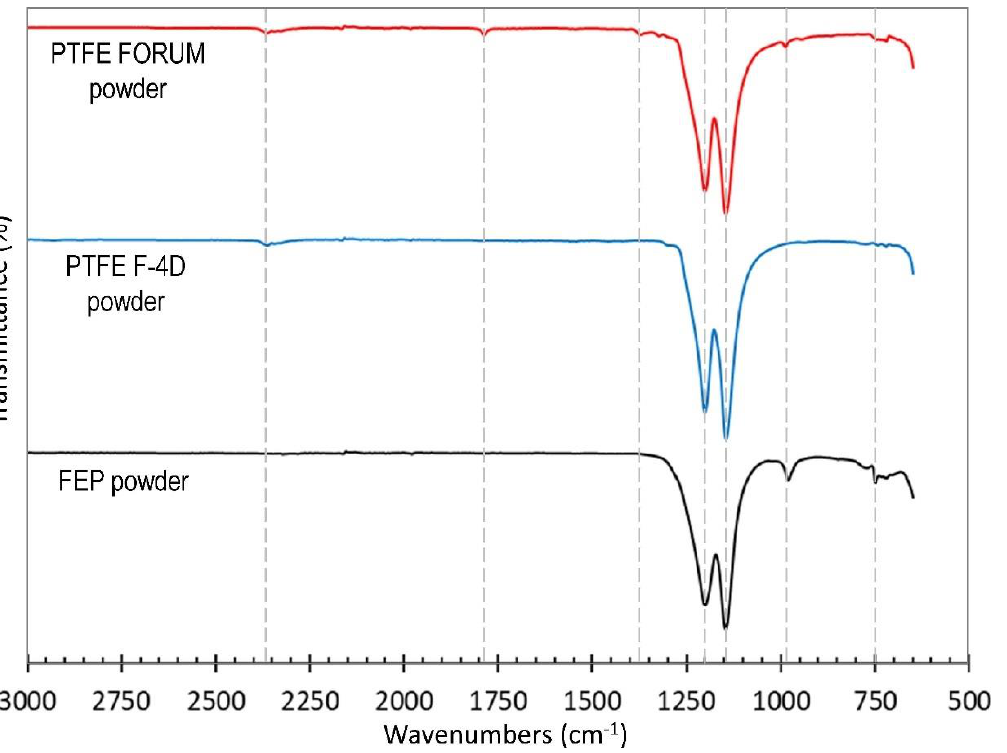
Figure 2. FTIR spectra of FEP, PTFE F-4D and nano PTFE FORUM powders. The FTIR spectra of FEP powder shows –CF 2 –CF 2 – bands at 1201.40 and